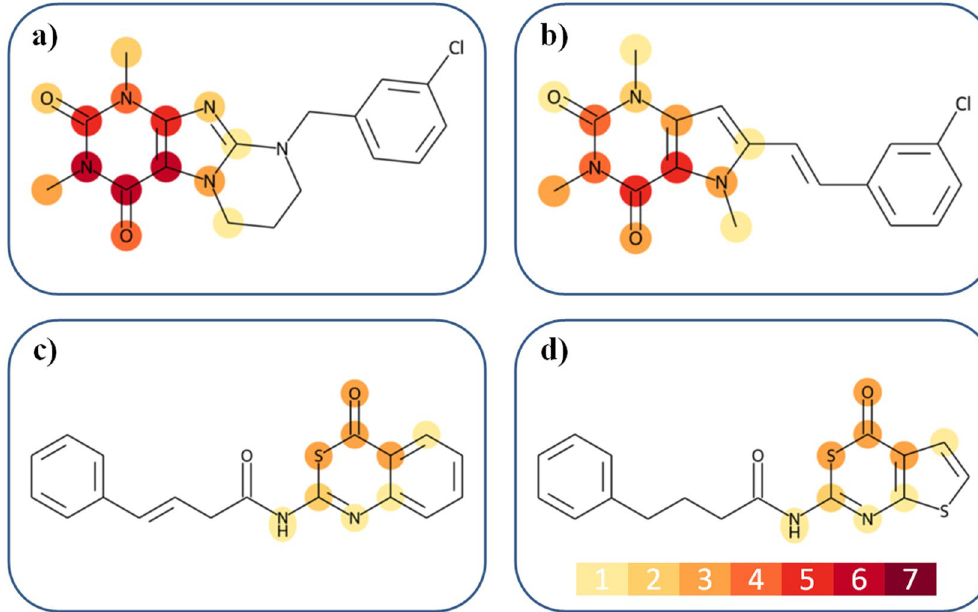
Figure 6. Feature mapping onto dual-target compounds from the first pair. Prioritized features are mapped onto to the structures of MAOB-A2aR DT-CPDs. Atoms are color-coded according to the number of features containing them, as indicated by the insert at the bottom of ( d ). Accordingly, the color code ranges from light yellow for atoms contained in one feature to dark red for atoms contained in seven features. Features determining the prediction of the compounds in ( a ) and ( b ) delineate a caffeine substructure while features contained in the compounds in ( c ) and ( d ) define a thiazine moiety.